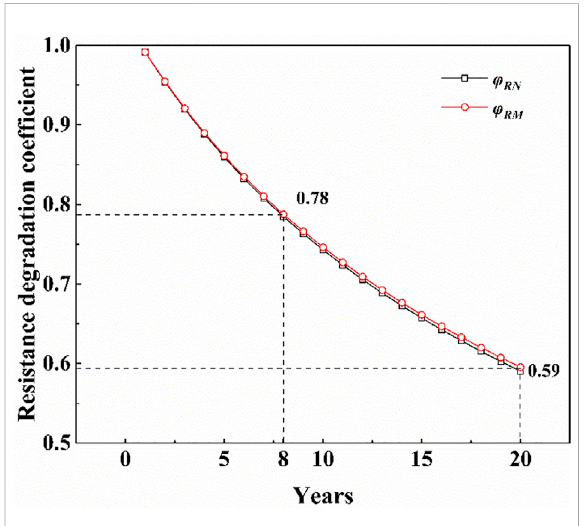
FIGURE 10 Resistance degradation coef fi cient of the steel